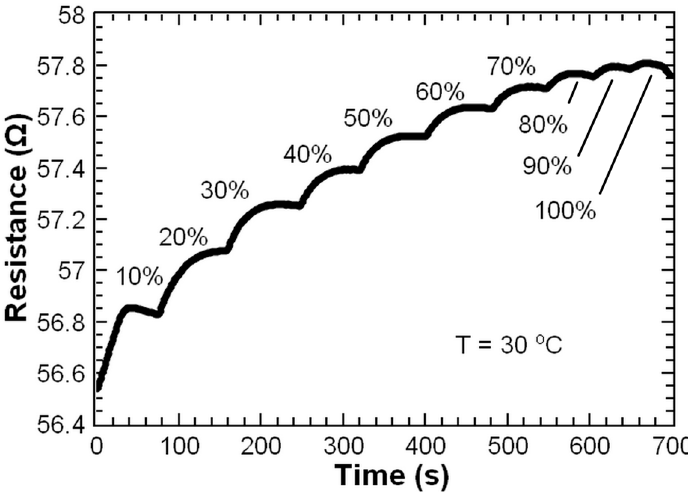
Figure 3. Sensor response to CO 2 across the full volume concentration range of 0% to 100%.